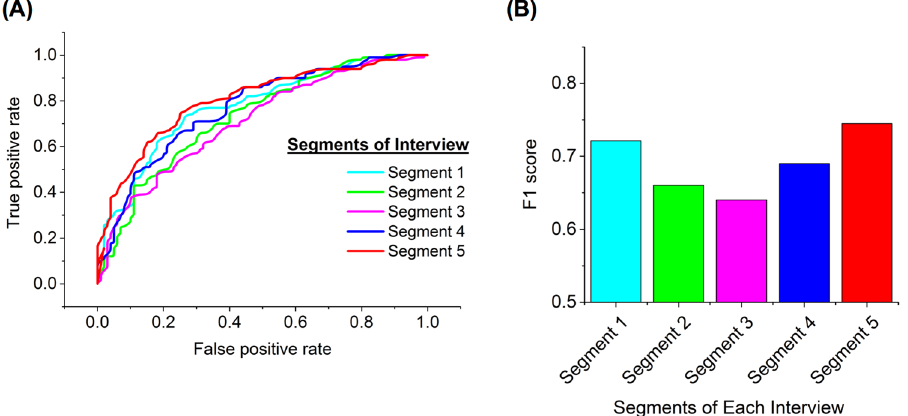
Figure 5. Random forest classifier performance for different segments of each interview. ( A ) ROC curves for classifiers using 5 different data profiles of FX premutation carriers and comparison group. These profiles created from a different segment of each interview, but with the same length. The first and last segments of the language samples provided the most amount of information for the classifier. The information provided in segment 3 resulted in the worst performance. ( B ) F1 score measures the test’s accuracy considering both precision and recall. The profile constructed from the last segment has a F1 score equal to 0.74, which indicates the best performance among the tested profiles from a particular segment of an